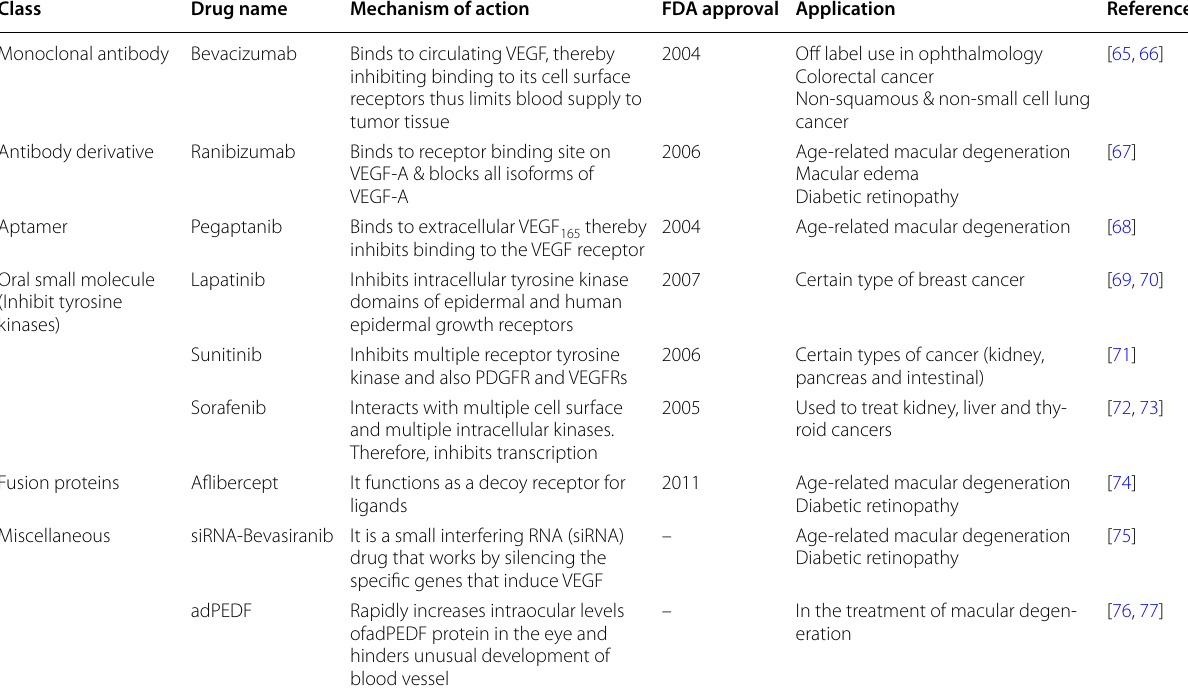
Table 2 Classification and application of anti-VEGF